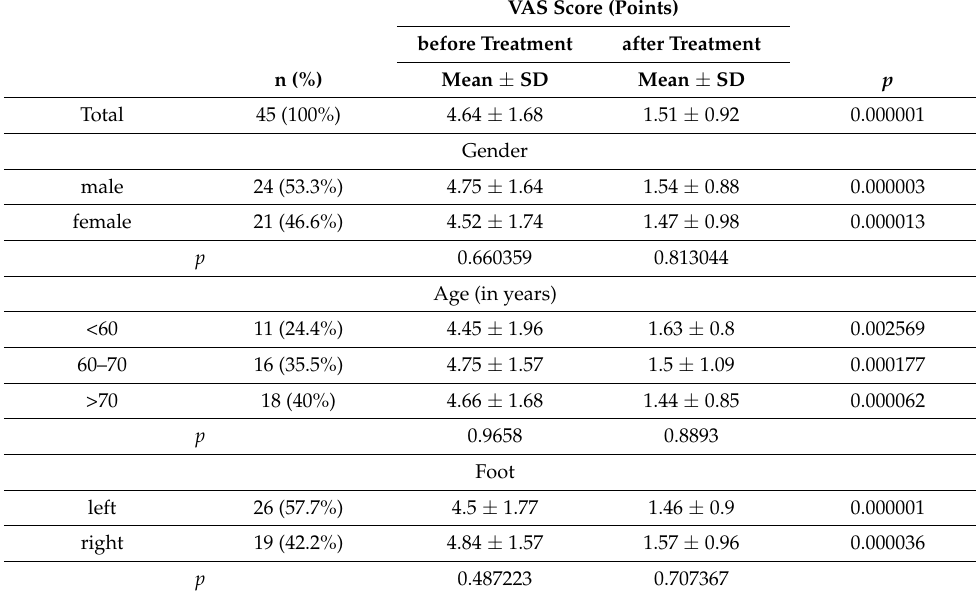
Table 2. The intensity of pain assessed using the VAS, before and after the end of local hyperbaric oxygen therapy procedures, for the whole group of patients and by gender, age, and ulcer location. VAS Score (Points)